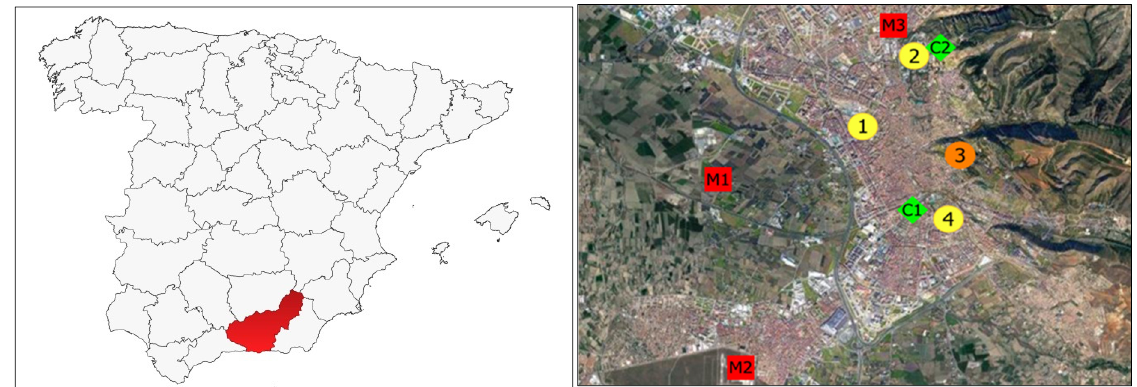
Figure 1. Location of the city of Granada and of the sampling points. 1: Fuentenueva Campus; 2: Cartuja Campus; 3: La Alhambra Forests; 4: Bola de Oro Sport Center; C1: Congress Palace station; C2: Cartuja Station; M1: IFAPA Station; M2: Air Base Station; M3: Cartuja Station. In relation to the Urban Green Infrastructure, there are 363 green elements registered